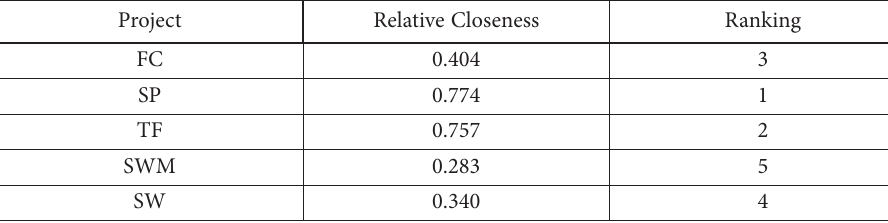
Table 10. Project relative closeness ranking table